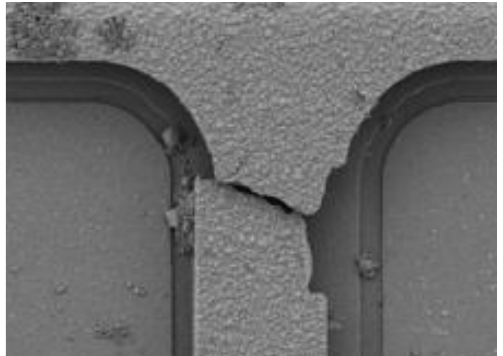
Figure 1. Failure of a suspension spring of a MEMS accelerometer, after [14] (© [2006]